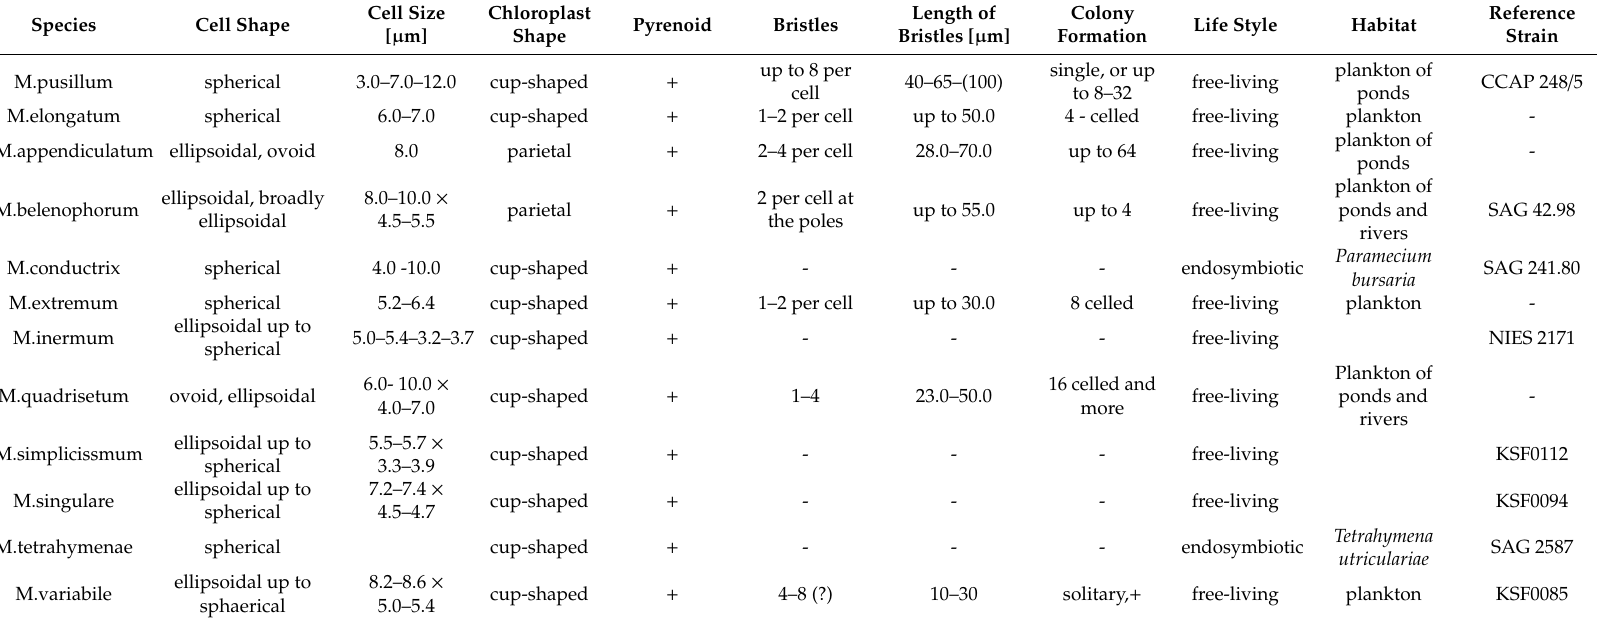
Table 1. Diacritical morphological features among the described species of